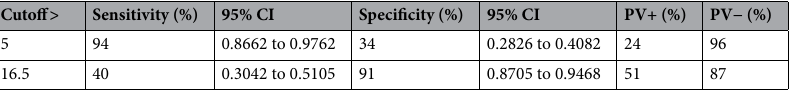
Table 5. Performance of SOM-1 in predicting in-hospital mortality. PV + : Positive predictive value, PV−: negative predictive